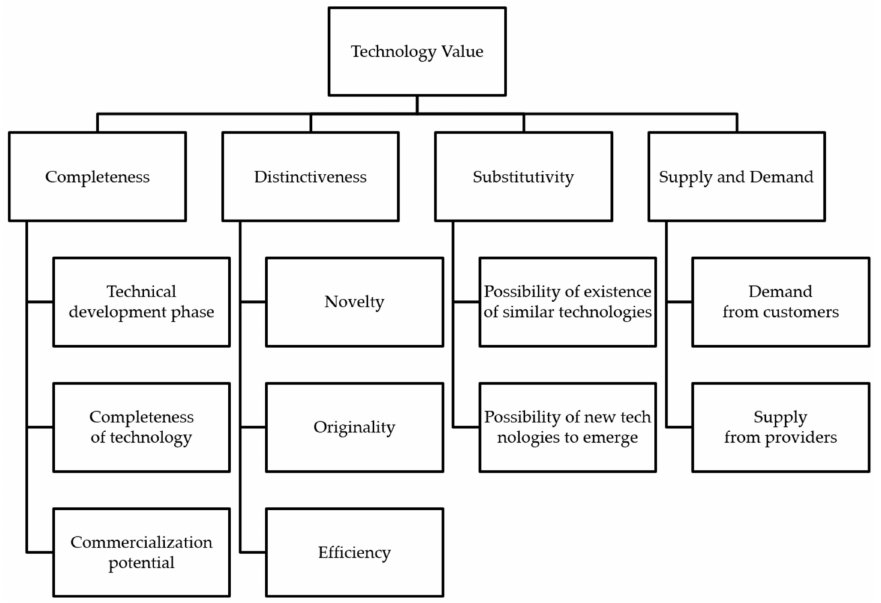
Figure 4. Hierarchy of floor plan analysis technology